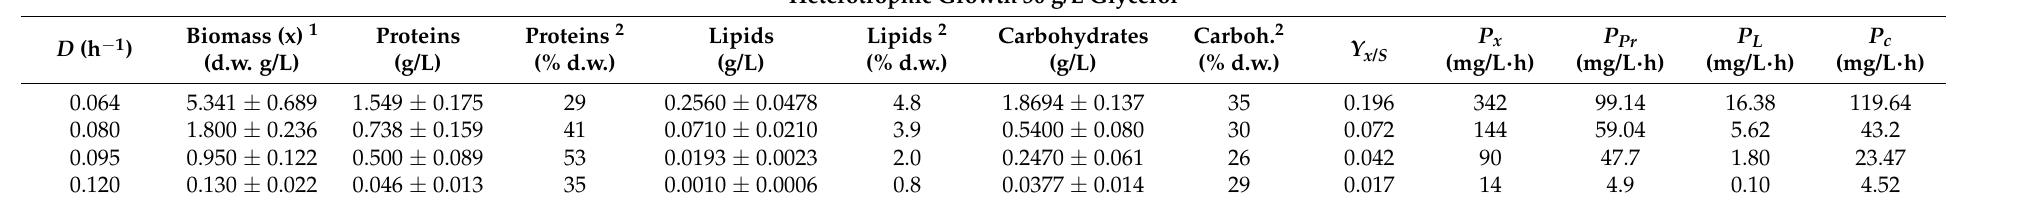
Table 1. Values of biomass, protein, lipids, and carbohydrates production (means ± SD) in a continuous flow culture of Auxenochlorella protothecoides with 30 g/L glycerol under heterotrophic conditions at steady state situations at various dilution rates ( D ). The productivities of biomass ( P x ) and metabolites ( P Pr for proteins, P L for lipids, and P c for carbohydrates) and yield coefficient on glycerol ( Y x/S ) were calculated by the equations: P x = D · x , P m = D · m and Y x/S = x/S asimilated , respectively (where S is the substrate -glycerol).